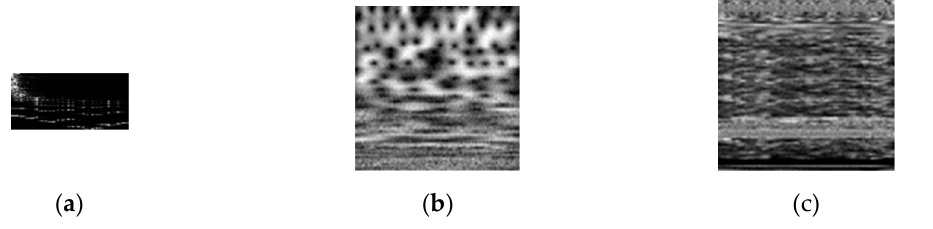
Figure 7. Three types of image samples corresponding to: ( a ) Frequency domain, size 128 × 62 (FD); ( b ) time-frequency domain (TFD), size 256 × 256; and ( c ) three-domains (ThD), size 256 × 265.